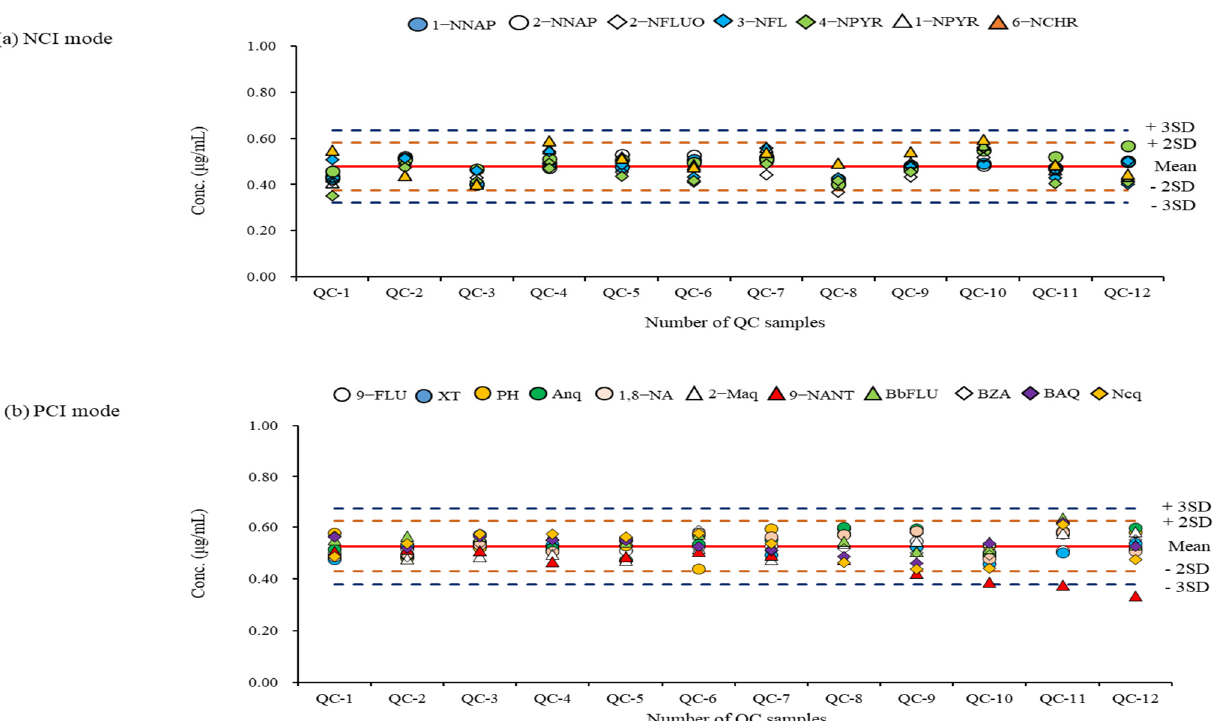
Figure 5. QC results during the period of sample analysis: (a) QC chart of analytes measured in NCI mode; (b) ) QC chart of analytes measured in PCI mode. The graph indicates that upper and lower warning and rejection limits for reference standard materials (0.5 ug/mL).